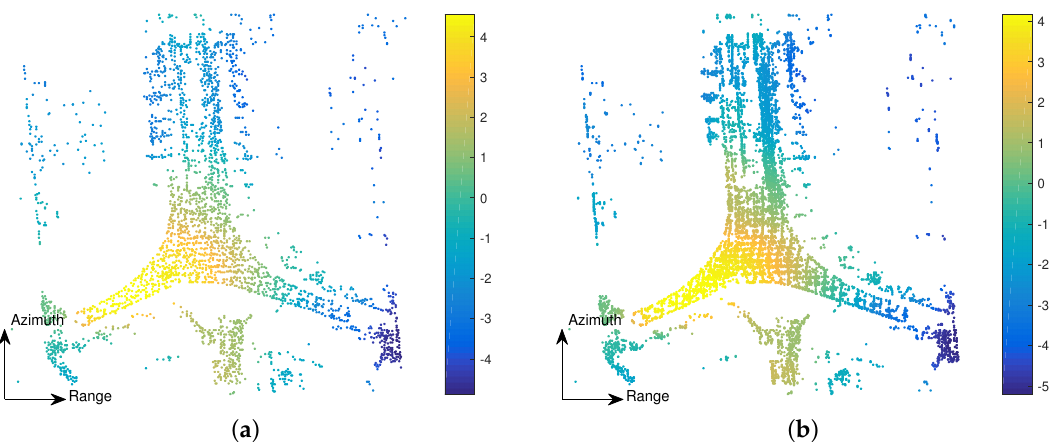
Figure 9. The mean deformation rate maps of PS in T3 E area by: ( a ) StaMPS; and ( b ) IStaMPS